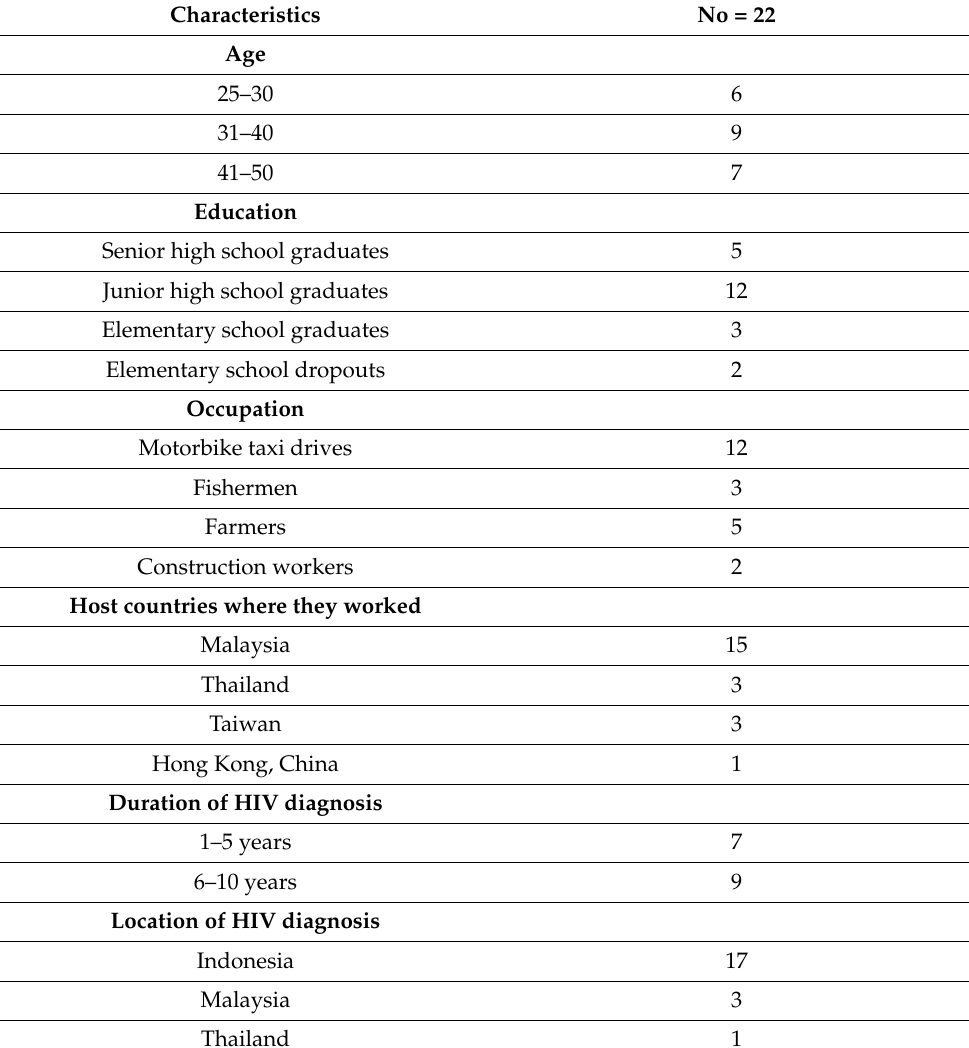
Table 1. Sociodemographic characteristics of the participants.